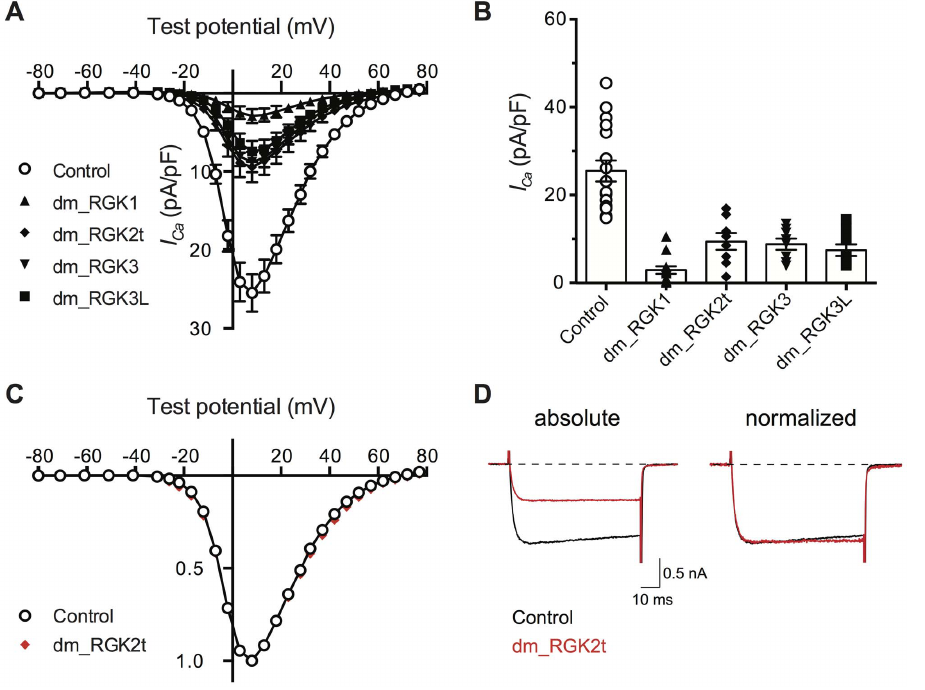
Figure 2. Fruit fly RGK-like protein homologs reduce I Ca density in rat sympathetic neurons. A. I-V plots in which mean 6 SEM I Ca density is plotted versus test potential. I Ca was evoked and acquired as described for Fig. 1. Control neurons (open circles) were not injected with cDNA (n=17). Neurons previously injected with Drosophila melanogaster RGK protein cDNA clones (50 ng/ m l approximately 18–24 hours prior to recording) are depicted with filled symbols: dm_RGK1 (triangle, n=13); dm_ RGK2t (diamond, n=8), dm_RGK3 (inverted triangle, n=8), and dm_RGK3L (square, n=9). B. Category plot of data shown in panel A for I Ca density at + 10 mV. Mean I Ca density for neurons expressing RGK protein clones differed significantly ( P , 0.05) from control (one-way ANOVA followed by Dunnett’s multiple comparisons test). C. Normalized I-V plots for control (open circle) and dm_RKG2t expressing (red filled diamond) neurons. Data, from panel A, was normalized to the maximal I Ca density and plotted to illustrate similarity of voltage-dependence. D. Exemplar I Ca traces acquired at + 10 mV from control (black) and dm_RGK2t (red) expressing neurons. Traces are depicted without (left) and with normalization (right) to maximal current. Dotted line represents zero current level.